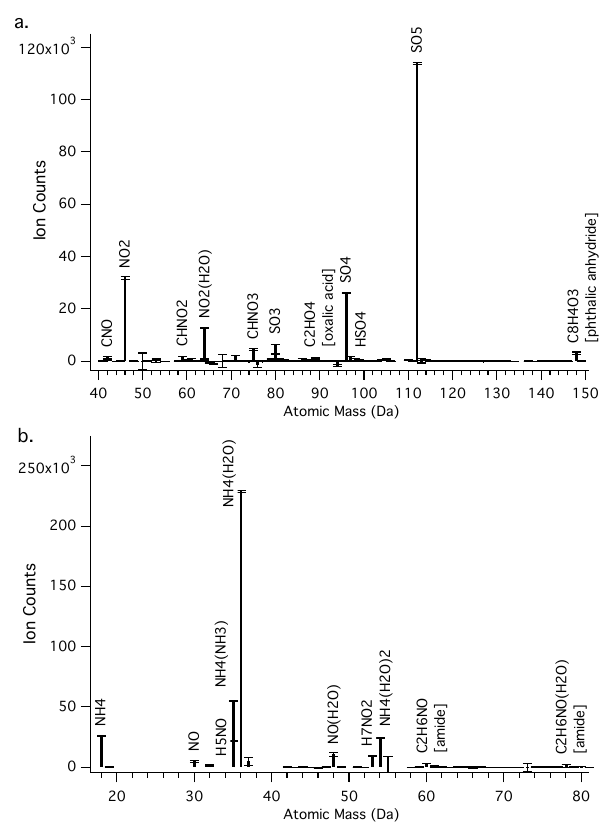
Figure 4. Calibration ammonium sulfate aerosol mass spectrum for (a) negative and (b) positive ions. SO − and SO − are the main 5 4 sulfate ions, and NO − indicates a nitrate contaminant in the stan- 2 dard, most likely introduced by the water or air used for the at- omization. The instrument is more sensitive to ammonium nitrate ) than to ammonium sulfate by a factor of ∼ 100 (detected as NO − 2 (Bzdek et al., 2014), so the nitrate contamination is likely a small fraction of the sampled aerosol mass. NH + and its clusters with wa- 4 ter and NH 3 are the main ammonium ions. All species plotted have one elemental